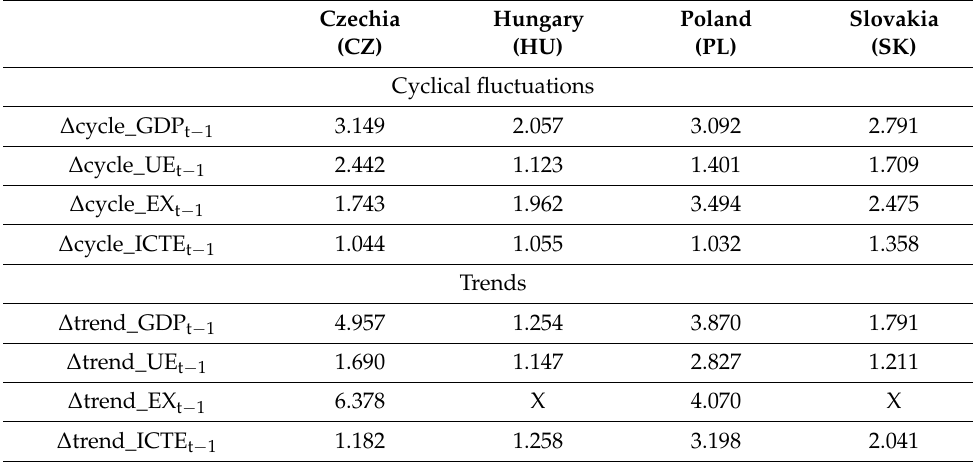
Table 3. Variance inflation factor (VIF) values of independent variables.